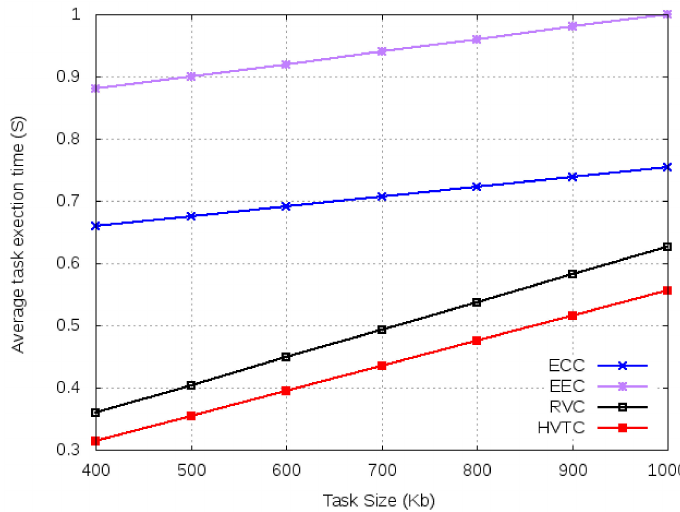
Figure 10. Average execution time for varied task